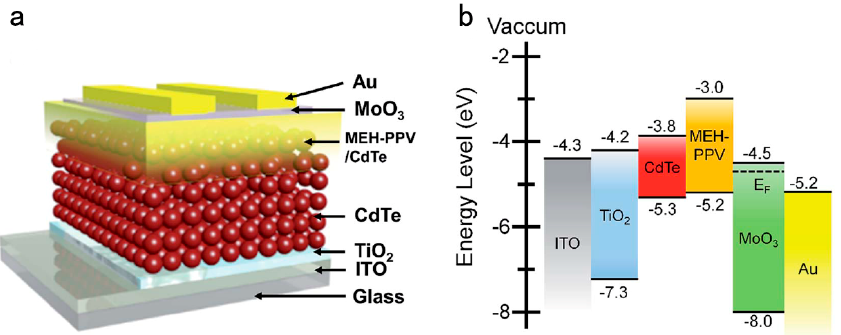
Figure 5. ( a ) HSC structure and ( b ) band alignment of different layers. EF represents the Fermi level. Reproduced with permission from [57], Copyright © 2016, Royal Society of Chemistry.